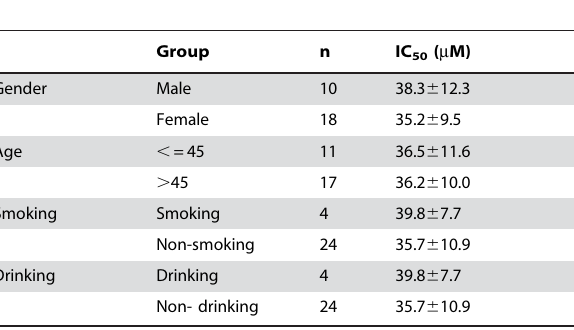
Table 1. Effect of donor gender, age, smoking and drinking on IC 50 of baicalin for CYP1A2 in HLMs mean 6 SD.